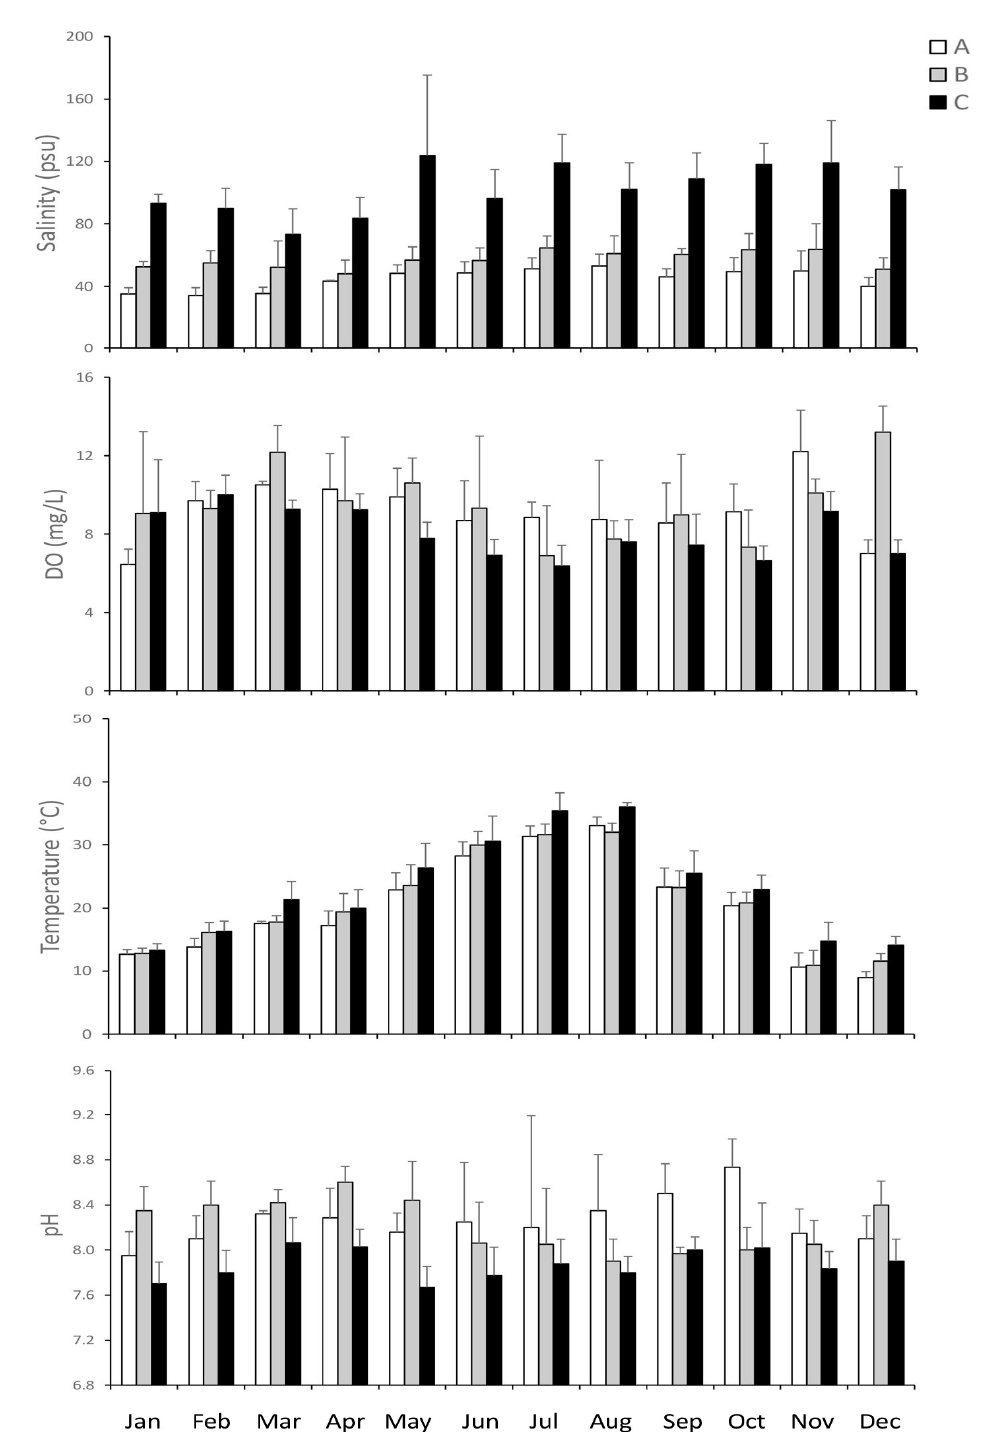
Figure 2. Mean values ( ± SE) for salinity, dissolved oxygen (DO), temperature and pH at sites A, B and C in each month of the year.